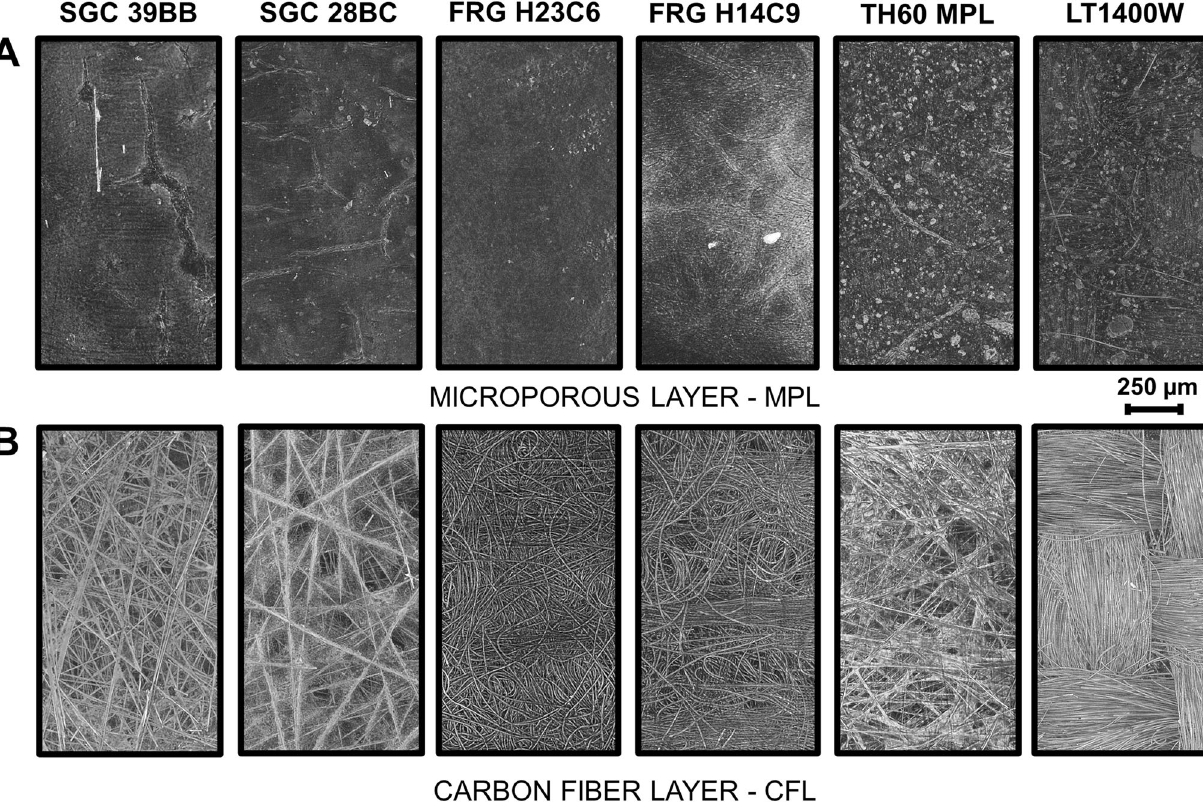
Fig. 4 Structure of different commercially available carbon gas diffusion layers. X-ray computed tomography of selected gas diffusion layers: ( A ) shows the side covered by the microporous layer, while ( B ) shows the other